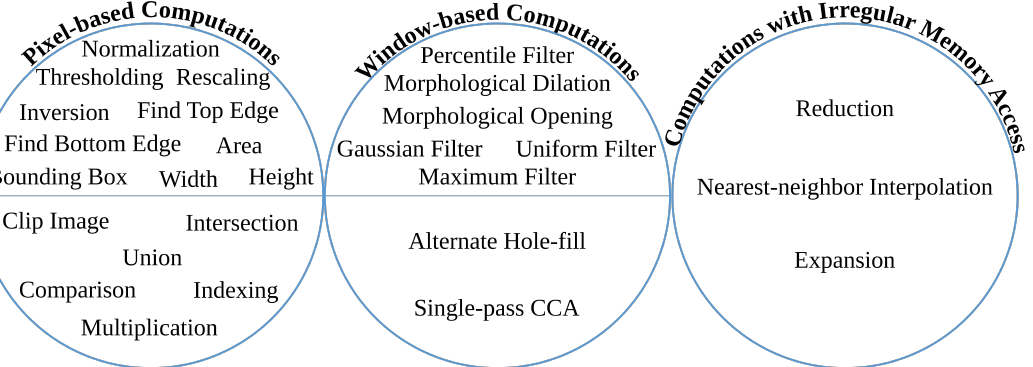
Figure 16. The system-level architecture of the i DocChip binarization